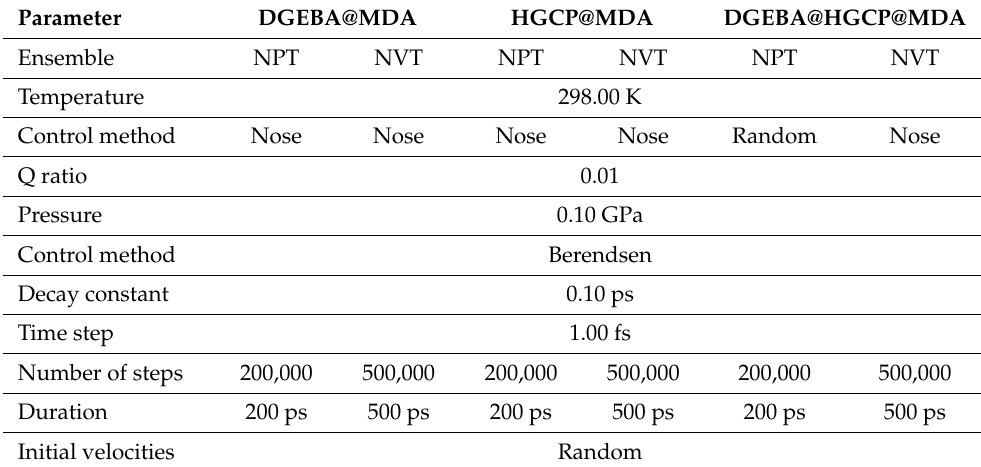
Figure 6. Schematic description of modeling systems of ( a ) DGEBA@MDA Initial Packing, ( b ) HGCP@MDA Initial Packing, ( c ) DGEBA@MDA with NPT, ( d ) HGCP@MDA with NPT, ( e ) DGEBA@MDA with NVP and ( f ) HGCP@MDA with NVP. Table 2. Dynamics parameters for (a) DGEBA@MDA, (b) HGCP@MDA, and (c) DGEBA@HGCP@MDA with ensemble NPT and